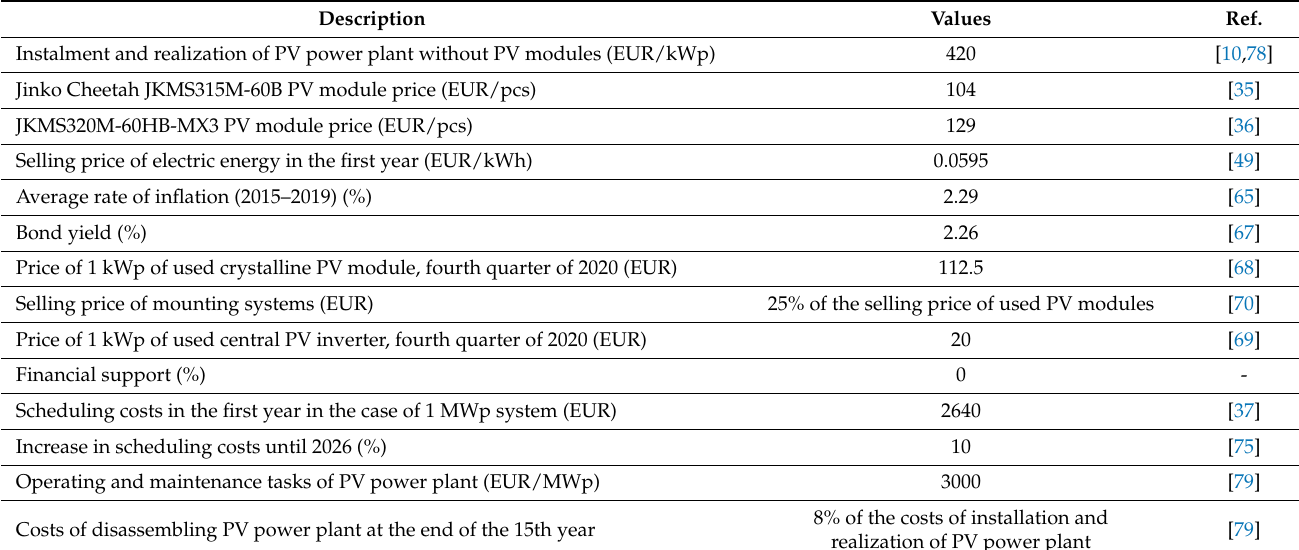
Table 3. Economic figures used in the